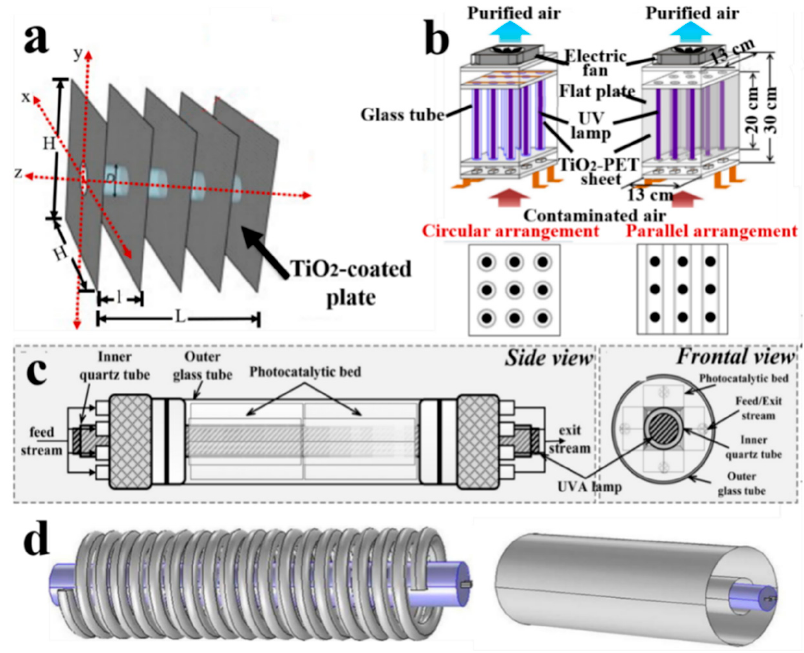
Figure 8. ( a ). Multi-plate photocatalytic reactor with one lamp and reactor performance parameters [99]. Copyright 2013, Elsevier. ( b ). Arrangement of UV lamps and TiO 2 -PET sheets [101]. Copyright 2017, Elsevier. ( c ). Schematic representation of the experimental set-up and the continuous-flow photoreactor [110]. Copyright 2015, Elsevier. ( d ). Gas phase photocatalytic reactor of the spiral reactor and actual spiral reactor [103]. Copyright 2017, Elsevier.